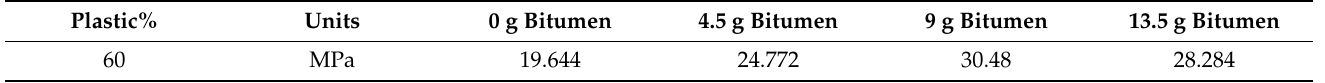
Table 5. Mean value of compression